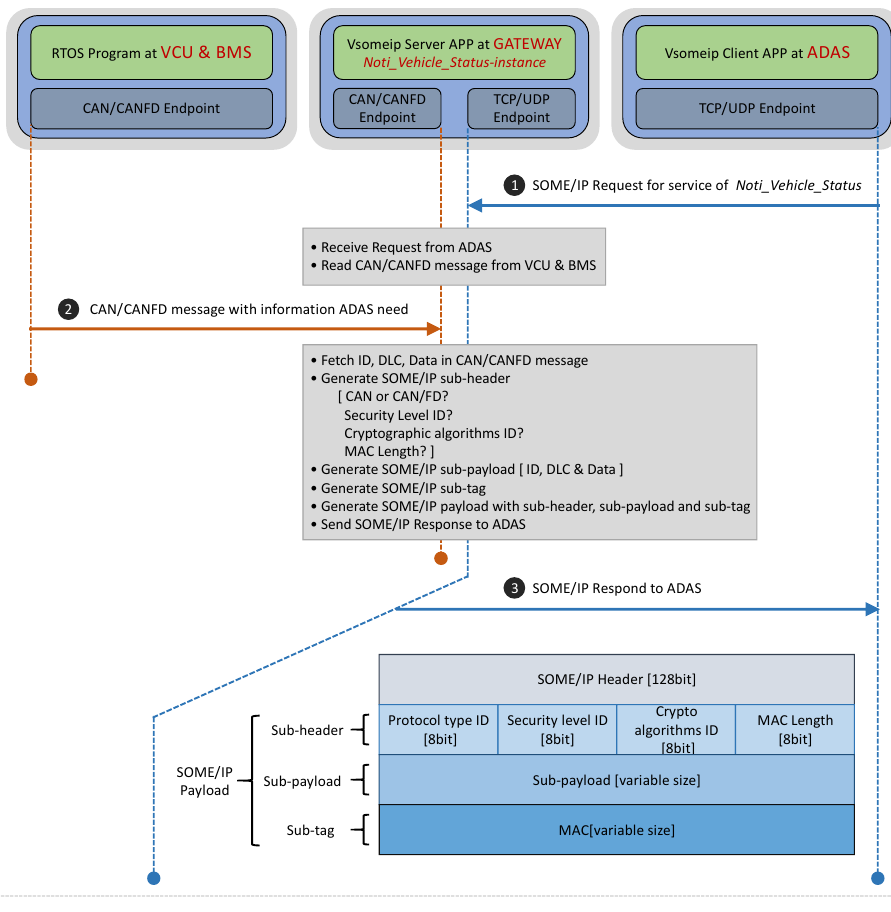
Figure 8. Workflow of the designed gateway.